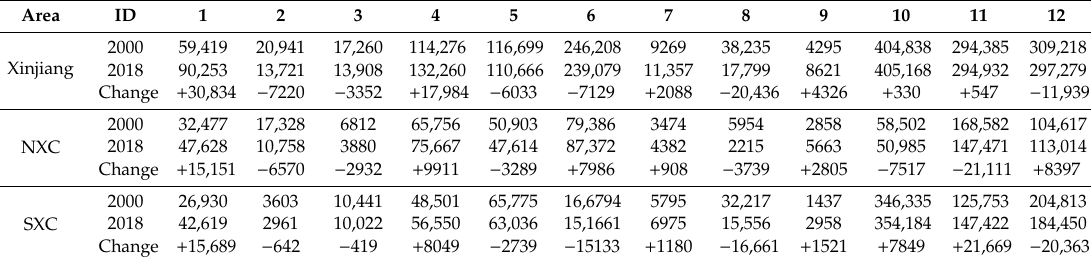
Figure 8. The LULC of Xinjiang in 2000 ( A ) and 2018 ( B ). HC, MC, and LC denote the high coverage, moderated coverage, and low coverage, respectively. Table 3. Statistics of the LULC in 2000 and 2018 (km 2 ).